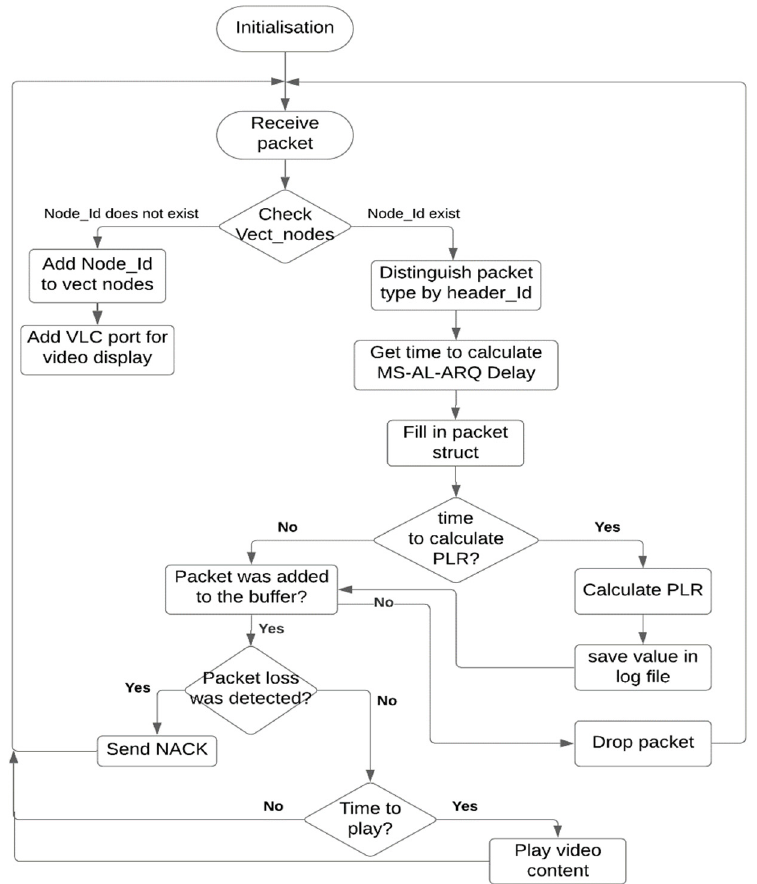
Figure 2. MS-AL-ARQ flow